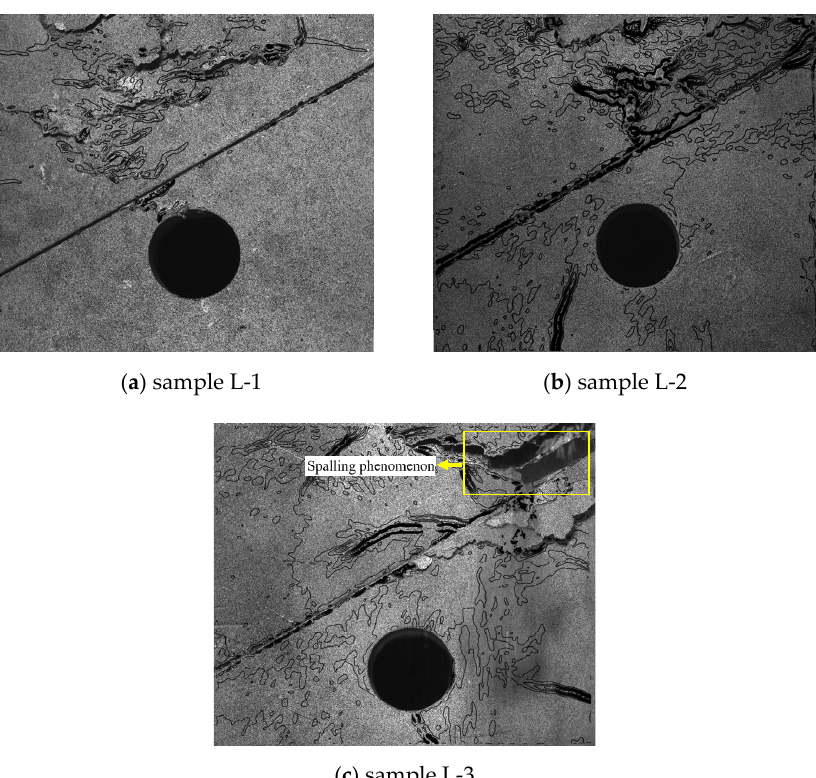
Figure 7. Fracture modes of granite samples with bonding fracture at different spacing distances L .